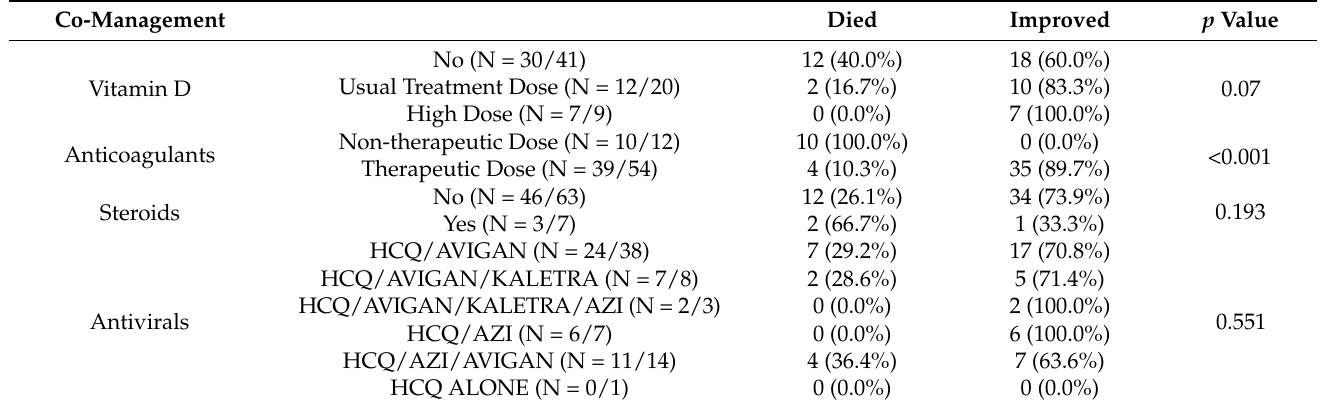
Table 3. The potential effect of co-management of vitamin D, anticoagulants, antivirals, and steroids with tocilizumab on COVID-19 outcome.